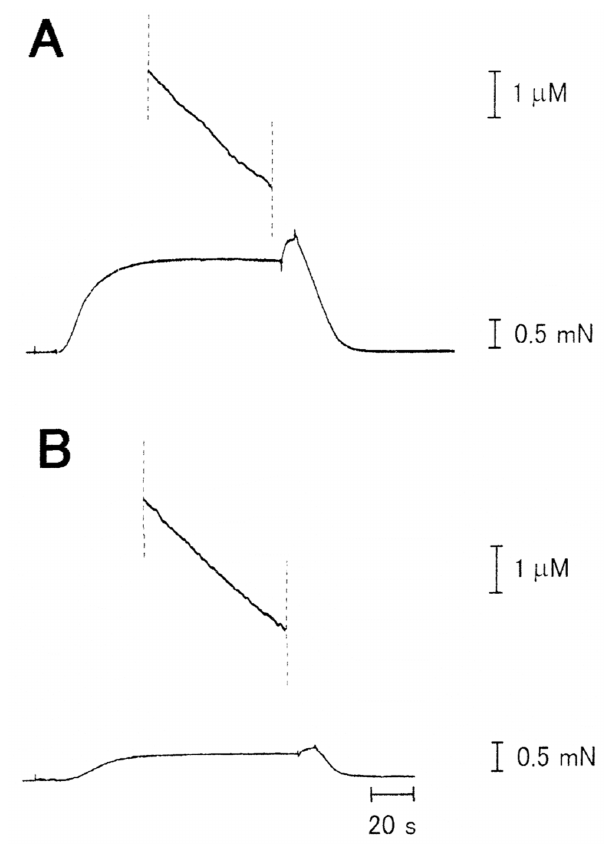
Figure 9. Simultaneous recordings of MgATPase activity (upper traces) and Ca 2 + -activated isometric force development (lower traces) of a small bundle consisting of two fibers. Records A and B are taken before and after application of anti-LD antibody (2 mg/ml), respectively. (myosin-myosin rod copolymer mixed at a ratio of 1:1) shown in Fig. 2B [10] has a length of , 1.5 m m and a diameter of , 90 nm. As a native myosin filament is 1.6 m m in length and 15 nm in diameter, the size of this particular filament roughly corresponds to a bundle consisting of 6 native myosin filaments running in parallel with one another. Considering that this filament is a 1:1 mixture of myosin and myosin rod, the number of myosin heads in it may be , 900 (300 6 6 6 1/2). Since antibodies can attach only one of the two myosin heads in each myosin molecule [10], the number of myosin heads available for antibodies is , 450. In addition, it seems likely that myosin heads located at the filament surface can only bind with externally applied antibodies. If this factor is taken into consideration, the number of myosin heads available for antibodies would be further reduced to , 200. In fact, close inspection of the synthetic filament shown in Fig. 2B [10] indicates that the number of gold particles attached to myosin heads via anti-CAD antibody is . 200. This may be taken to indicate the high affinity of anti-CAD antibody to myosin head. In the case of a large synthetic filament shown in Fig. 2A [10], however, the number of gold particles attached to myosin heads is not so large, probably because antibodies may not readily accessible to myosin heads due to complex myosin-myosin rod network. We made similar observations on electron micrographs of synthetic filaments, in which myosin heads were position- marked with anti-RLR and anti-LD antibodies [11].